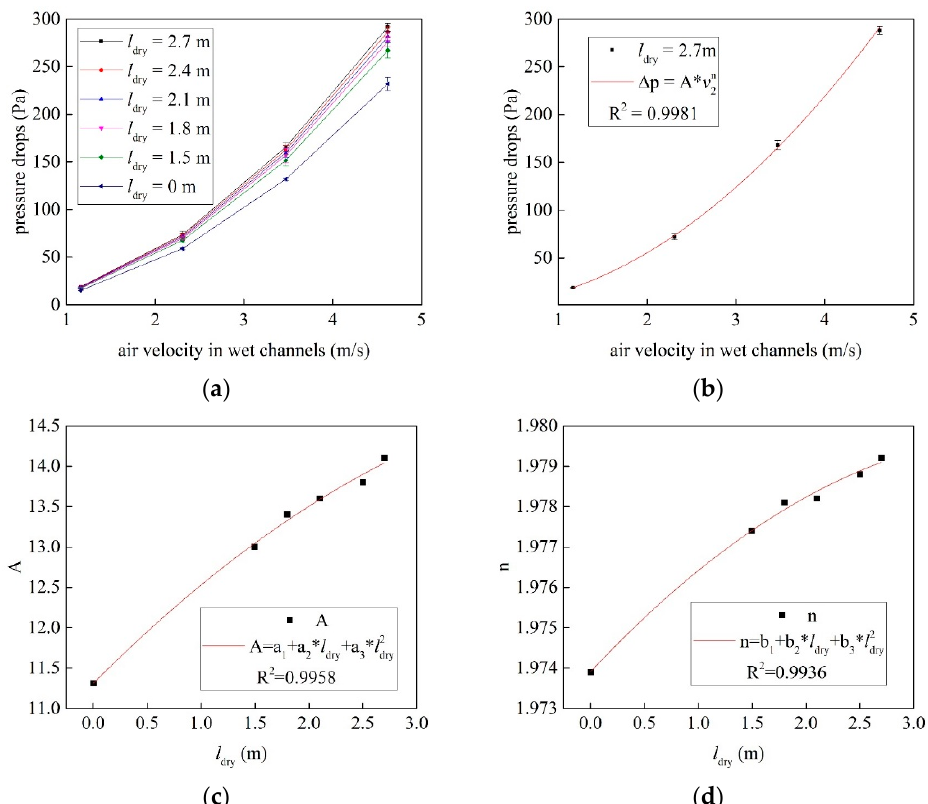
Figure 11. Impact of air velocity in wet channels on the pressure drops of the novel fills: ( a ) ∆ p vs. v 2 with different l dry ; ( b ) fitting equation for ∆ p vs. v 2 ; ( c ) fitting equation for A vs. l dry ; ( d ) fitting equation for n vs. l dry